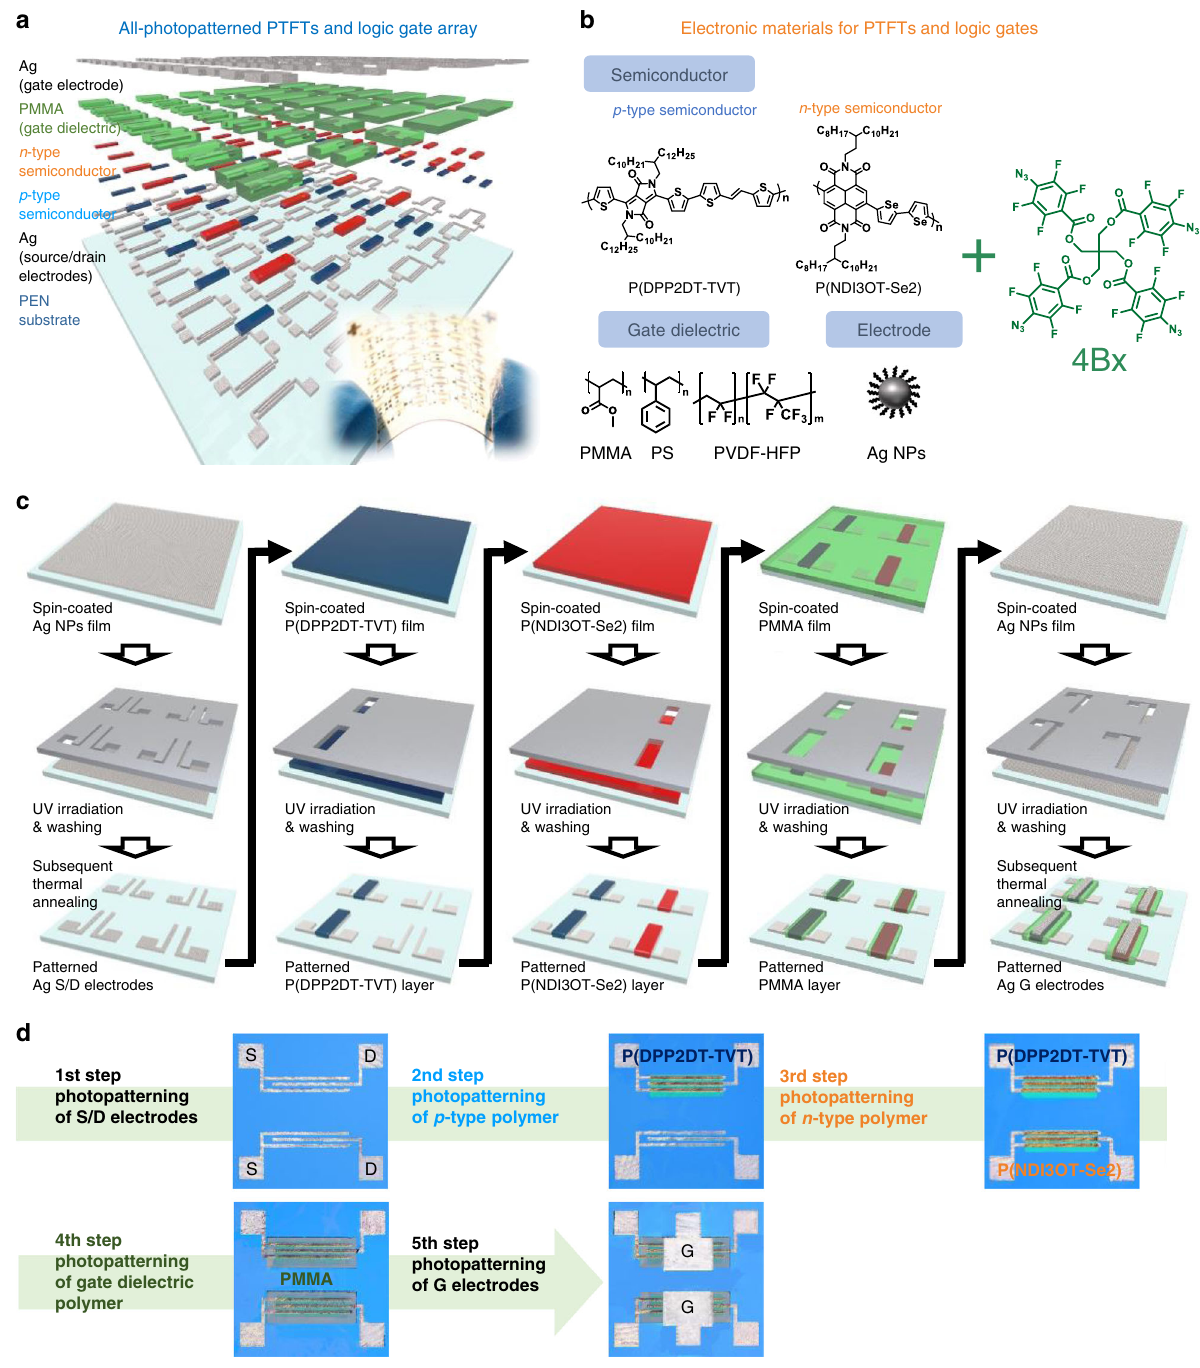
Fig. 1 All-solution-processed, all-photopatterned PTFTs and logic circuits. a Schematic drawing and photographic image of all-photopatterned PTFTs and logic circuits fabricated on a plastic substrate by patterning of semiconducting channel, gate dielectric, and electrode materials. b Chemical structures of electronic materials used in this study. c Schematic description of the fabrication processes for p - and n -type PTFTs through all-photopatterning using 4Bx. d Optical microscopy images of the component layers for a PTFT taken after each patterning